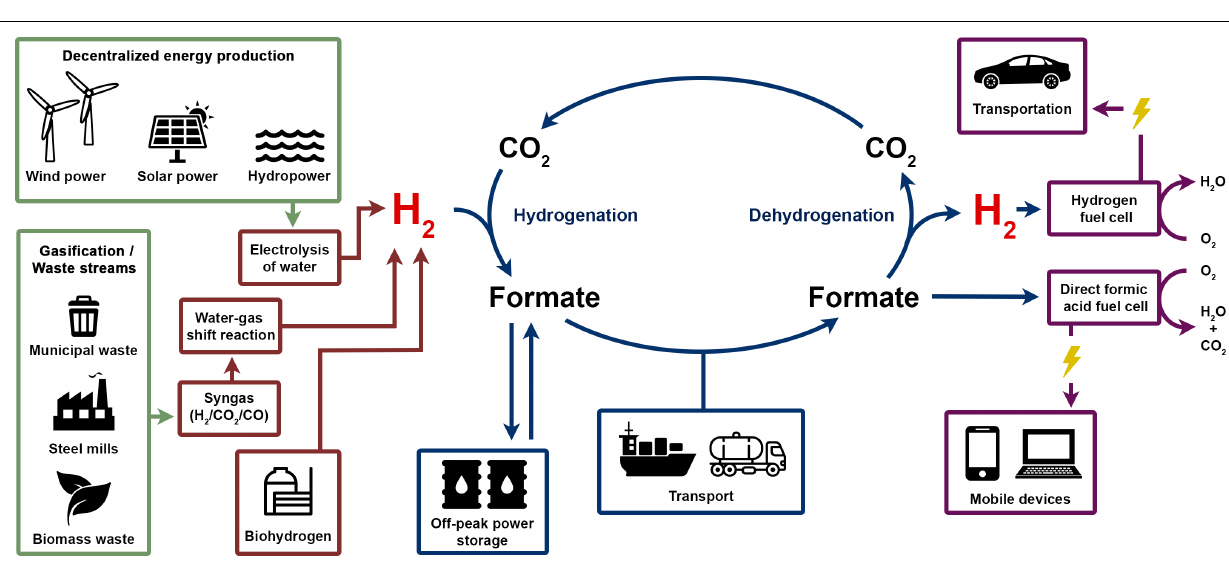
FIGURE 9 | Formate storage and the H 2 economy and envisioned H 2 economy could use sustainably produced electricity, biohydrogen or gasified waste as sources for H 2 gas. Hydrogenation of CO 2 leads to formic acid/formate which can be stored and transported easier, safer and in a more compact form compared to gaseous H 2 . Formic acid can serve as fuel directly in a direct formic acid fuel cell or formate is dehydrogenated to release H 2 again to be used in a H 2 fuel cell in, e.g., fuel cell powered